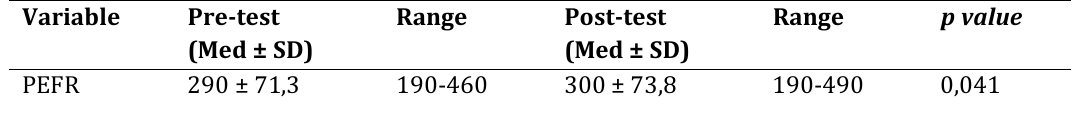
Table 2 The analysis of Peak Expiratory Flow Rate (PEFR) at the Kedungkandang Primary Health Care